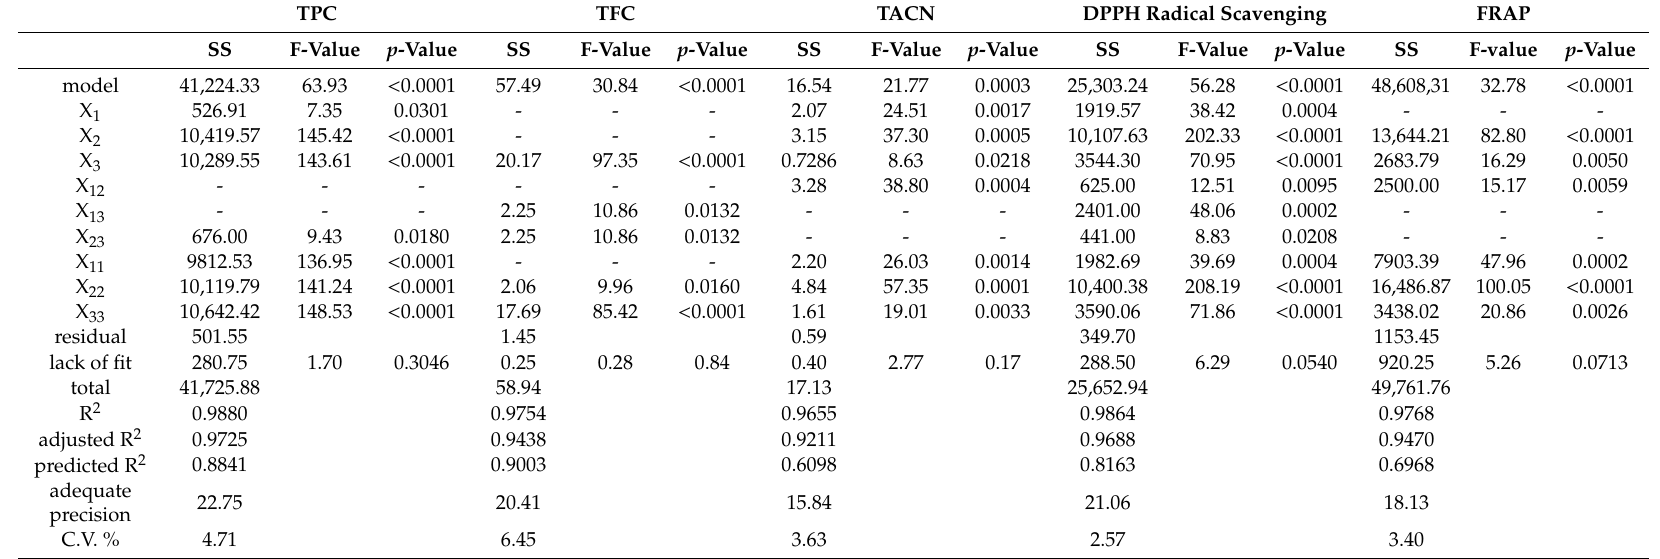
Table 4. ANOVA results for the reduced quadratic